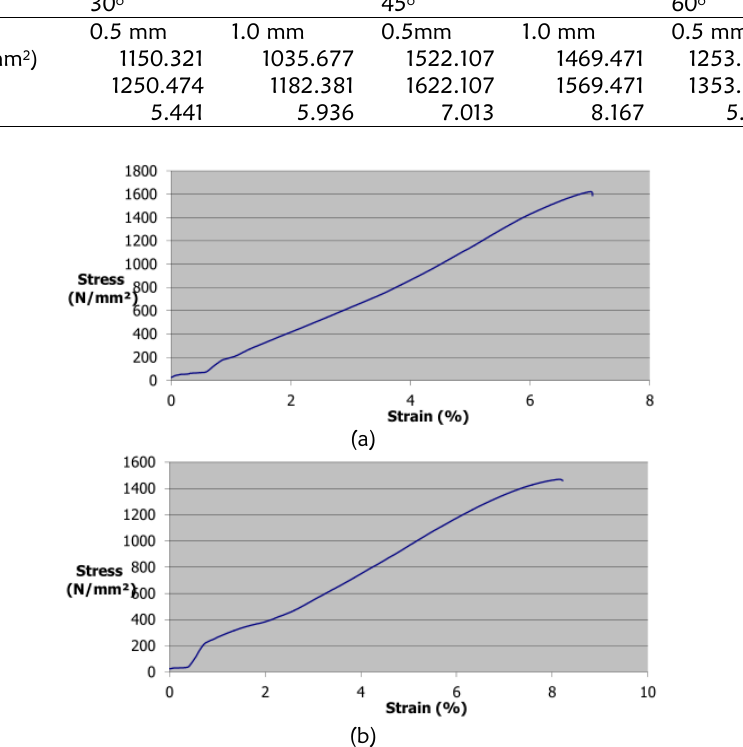
Figure 3: Stress against strain of HCS at 45° notch angle and (a) 0.5 mm, (b) 1.0 mm tip